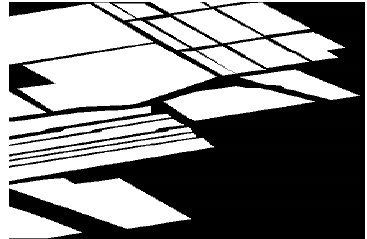
Figure 12. Grayscale image of